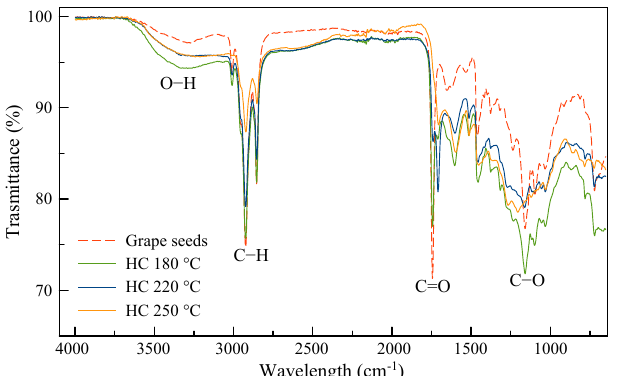
Figure 4. Fourier transform infrared spectroscopy (FTIR) curves of grape seeds and hydrochars (HC).